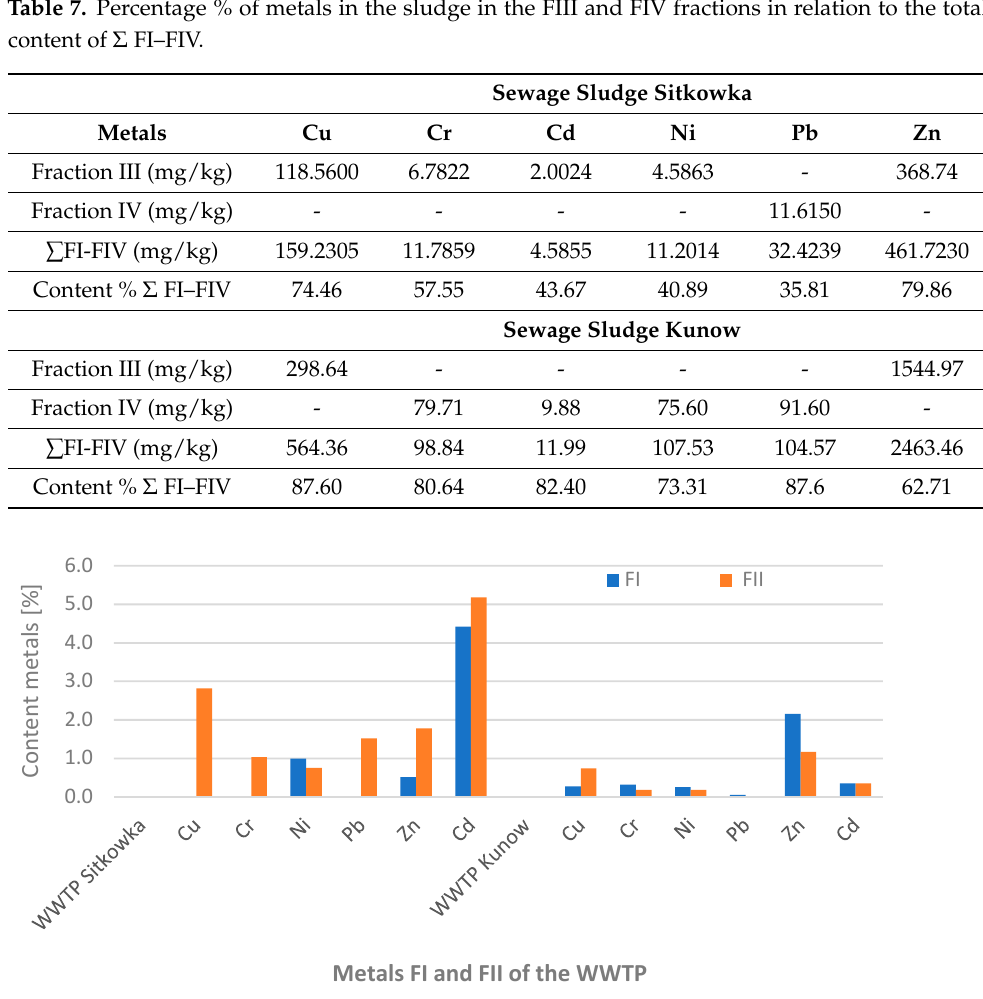
Figure 3. Percentage % of metals in the FI and FII fractions of the sludge of WWTP Sitkowka and WWTP Kunow in relation to the Polish standard [9].